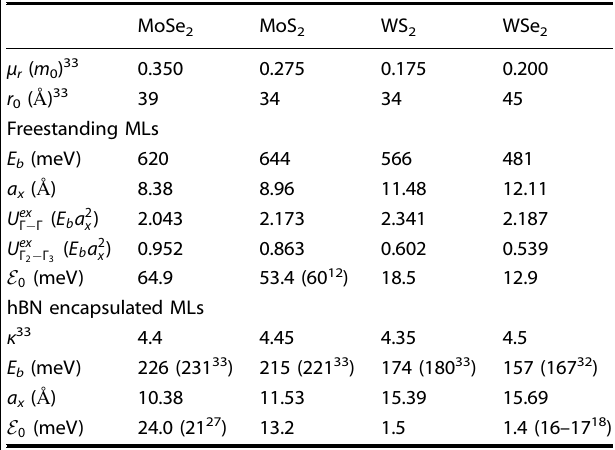
Table 1. Input parameters and calculated characteristics of excitons, their interactions, and the biexciton.